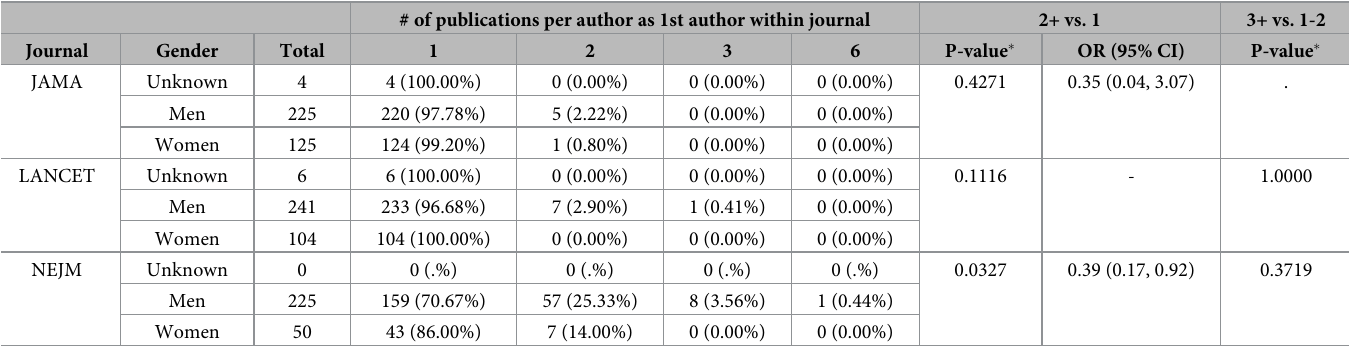
Table 8. First authors with multiple publications by journal by gender.